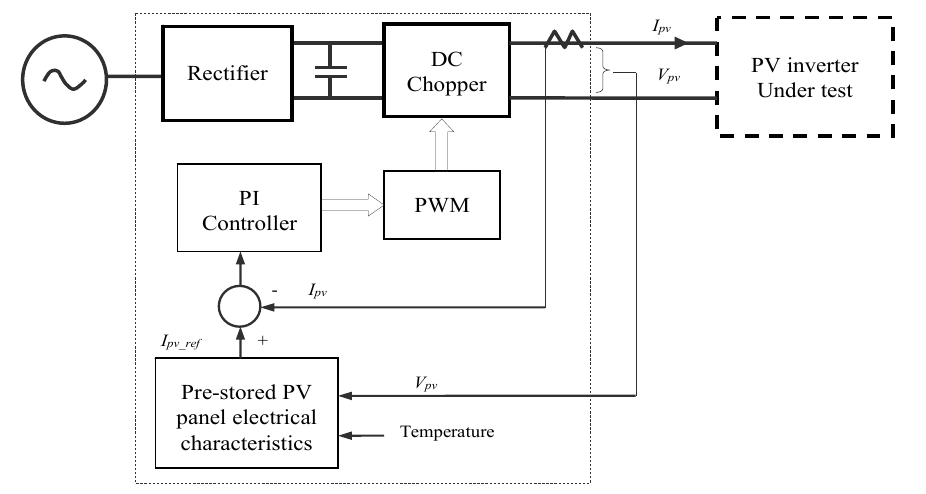
Figure 7. Block diagram of switching mode circuit based PV simulator.